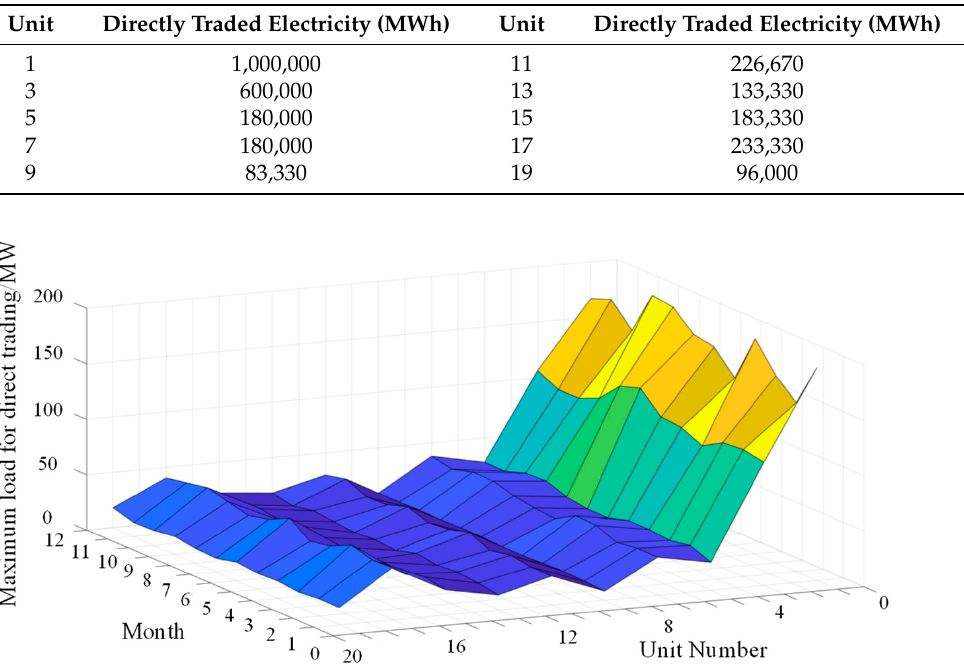
Table 3. Market energy for power units participated in market transactions.